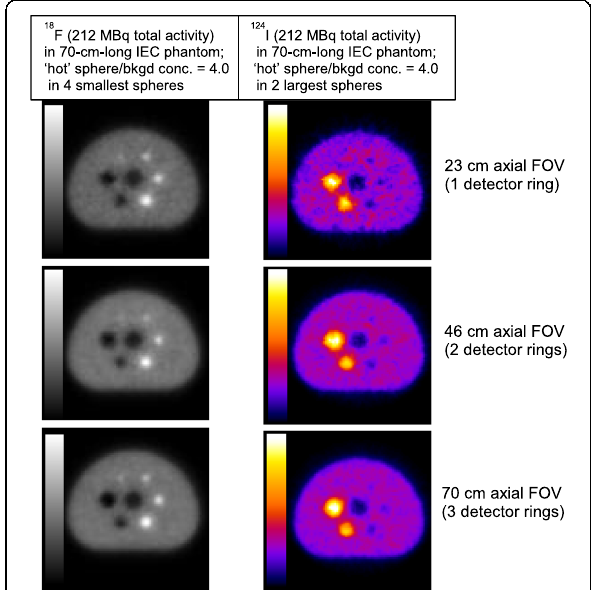
Fig. 2 (abstract A24). 18 F and 124 I TOF histo-images, obtained by backprojection of attenuation-corrected histo-projections. The three image rows from top to bottom correspond to simulated 2.5-minute simultaneous acquisitions of both tracers using, respectively, 1, 2, and 3 axial PennPET Explorer detector rings, showing progressively reduced image noise for the longer PET systems. The 124 I images in the right- hand column were made solely from triple-coincidence events. The 124 I histo-projections were scaled, using the known efficiencies for double- and triple-coincidence events, and then subtracted from the total double-coincidence histo-projections to estimate the TOF data for 18 F alone. The resulting 18 F histo-images are shown in the left-hand column. These separated histo-images will be used to initialize a simultaneous joint reconstruction of both tracer distributions from all recorded double- and triple-coincidence events using